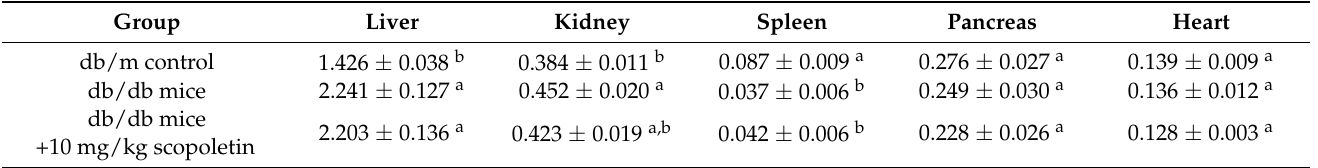
Table 1. Organ weights in db/m control and db/db